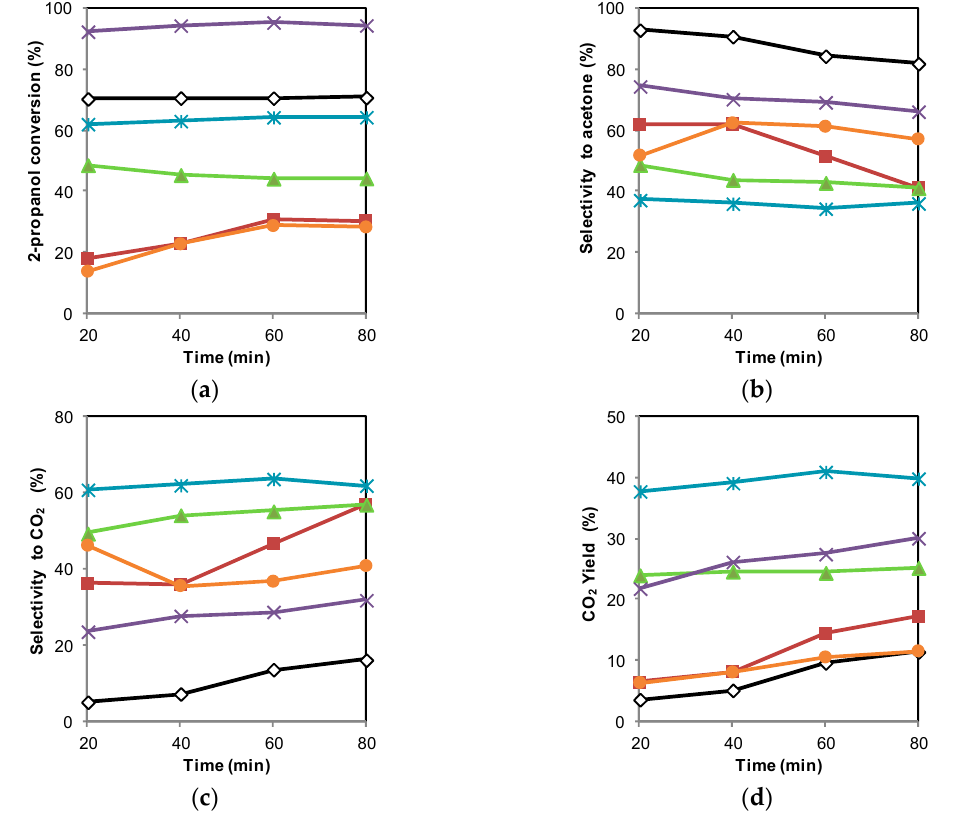
Figure 2. Photocatalytic 2 ‐ propanol oxidation over: TiO 2 (  ), CeO 2 (  ), TiO 2 ‐ 10%CeO 2 (  ), Au/TiO 2 Figure 1. Photocatalytic H 2 production at 30 °C under ultraviolet (UV) irradiation over: TiO 2 (  ), Figure 1. Photocatalytic H 2 production at 30 °C under ultraviolet (UV) irradiation over: TiO 2 (  ), Figure 2. Photocatalytic 2-propanol oxidation over: TiO 2 ( Figure 1. Photocatalytic H 2 production at 30 °C under ultraviolet (UV) irradiation over: TiO 2 (  ), (  ), Au/CeO 2 (  ) and Au/TiO 2 ‐ 10%CeO 2 (  ): ( a ) 2 ‐ propanol conversion; ( b ) Selectivity to acetone; ( c ) CeO 2 (  ), TiO 2 ‐ 10%CeO 2 (  ), Au/TiO 2 (  ), Au/CeO 2 (  ) and Au/TiO 2 ‐ 10%CeO 2 (  ). CeO 2 (  ), TiO 2 ‐ 10%CeO 2 (  ), Au/TiO 2 (  ), Au/CeO 2 (  ) and Au/TiO 2 ‐ 10%CeO 2 (  CeO 2 (  ), TiO 2 ‐ 10%CeO 2 (  ), Au/TiO 2 (  ), Au/CeO 2 (  ) and Au/TiO 2 ‐ 10%CeO 2 (  ). CeO 2 (  ), TiO 2 ‐ 10%CeO 2 (  ), Au/TiO 2 (  ), Au/CeO 2 (  ) and Au/TiO 2 ‐ 10%CeO 2 (  ). Selectivity to CO 2 ; ( d ) Yield to CO 2 .